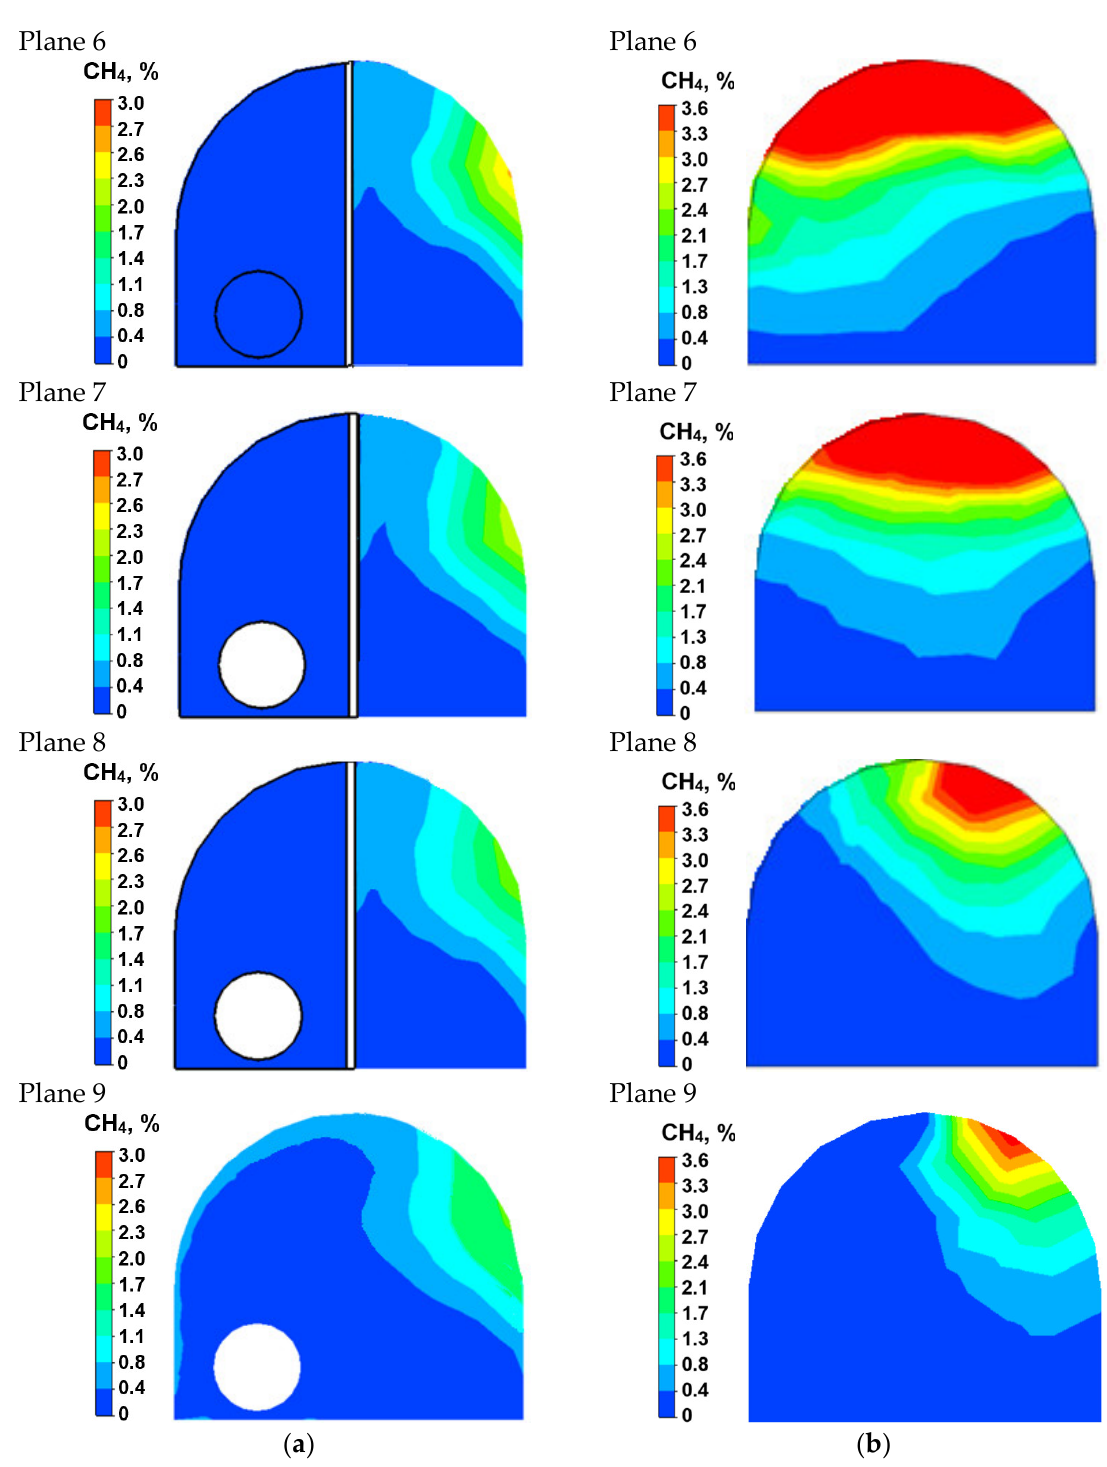
Figure 12. The distributions of methane concentrations in selected vertical sections (Planes 6–9) of the tailgate with built-in AVE ( a ) and without such equipment ( b ).